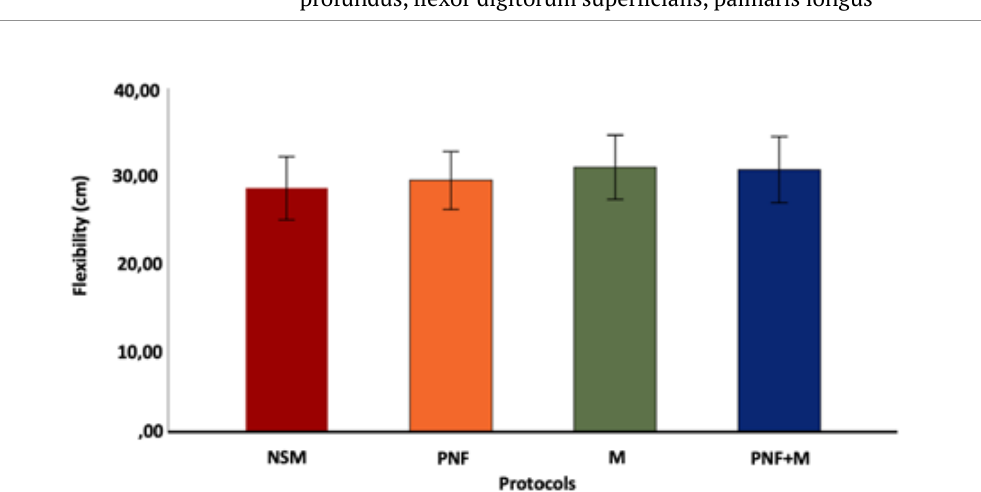
Figure 1. Flexibility performance of four warm up and stretching protocols